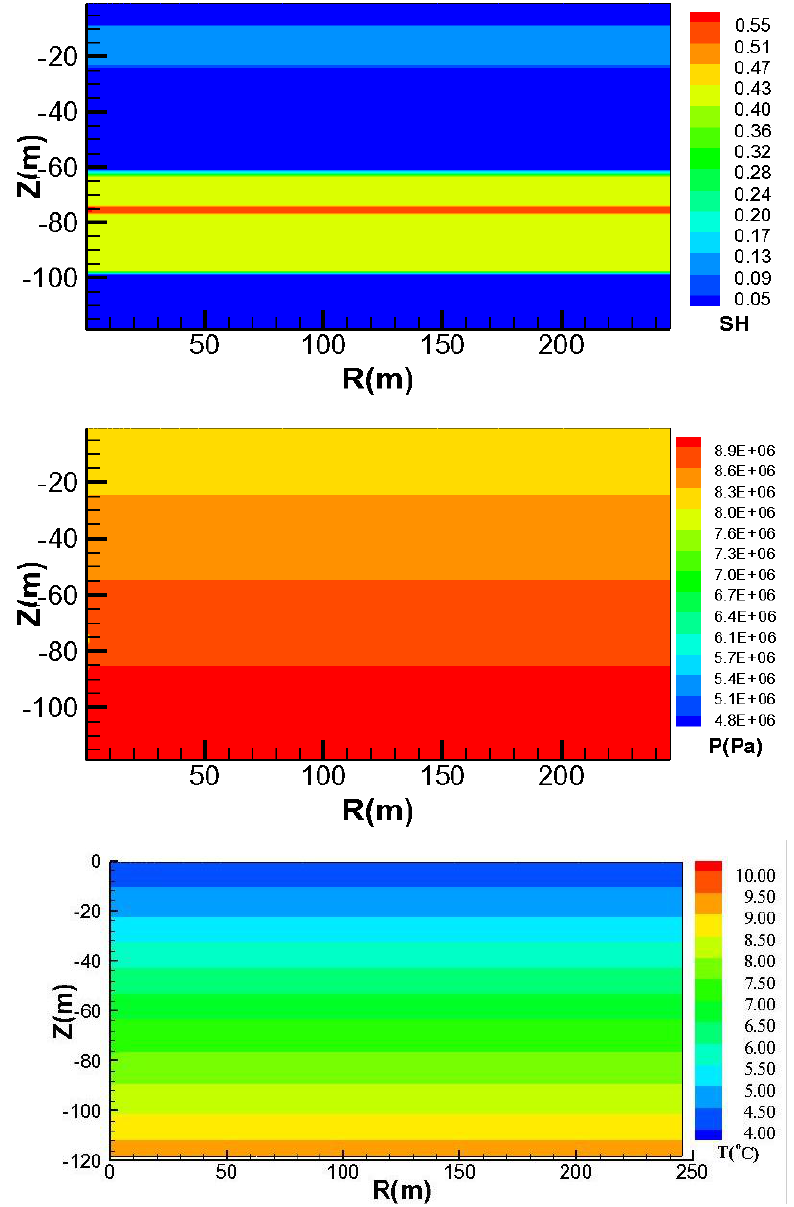
Figure 6. Spatial distributions of hydrate saturation, pressure, and temperatureat t = 0 day.